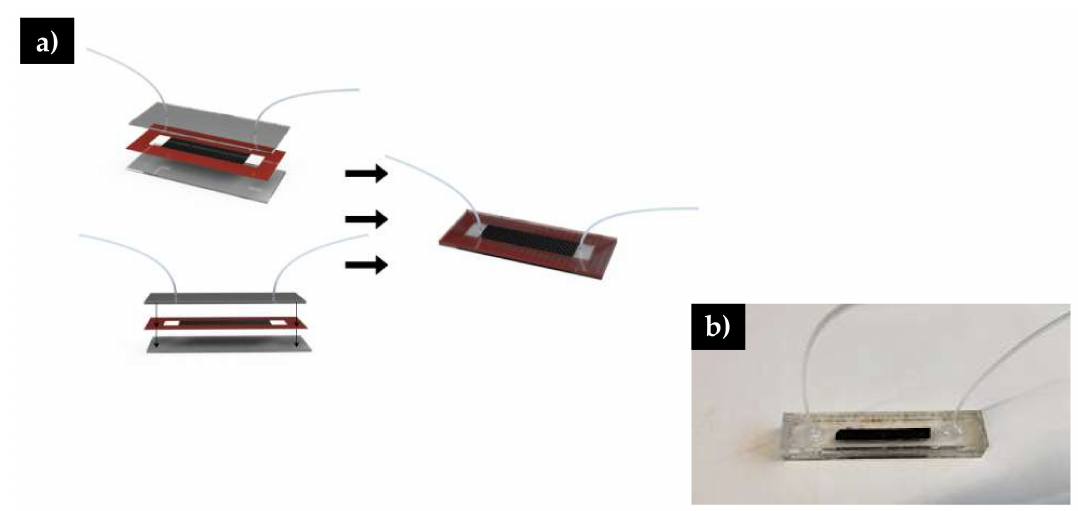
Figure 2. a ) Schematic of microfluidic channel assembly. Double sided tape is highlighted in red b